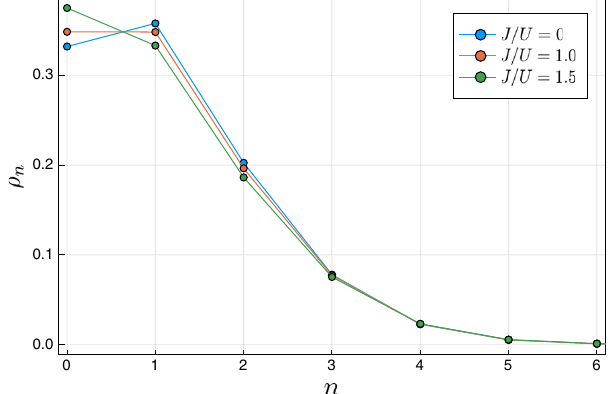
FIG. 9. Steady-state populations of the reduced density matrix ρ n j ρ n i , within DMFT NCA, for different values of the n ¼ h s j hopping-to-interaction ratio J=U and for drive-to-loss ratio r ¼ 1 . 22 . We see that increasing J=U changes the populations at low values of n and ultimately washes away the population inversion found in the single-site limit J=U ¼ 0 . Parameters: z ¼ 50 and dim 10 . The drive-to-loss ratio value used is marked H ¼ on the y axis in Fig. 10.